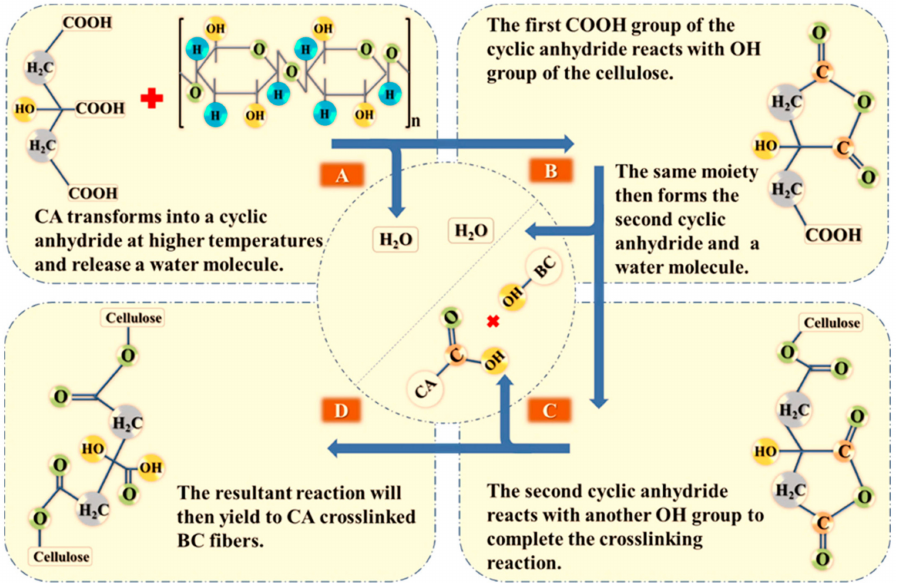
Figure 3. Schematic diagram of the proposed CA crosslinking mechanism on BC.